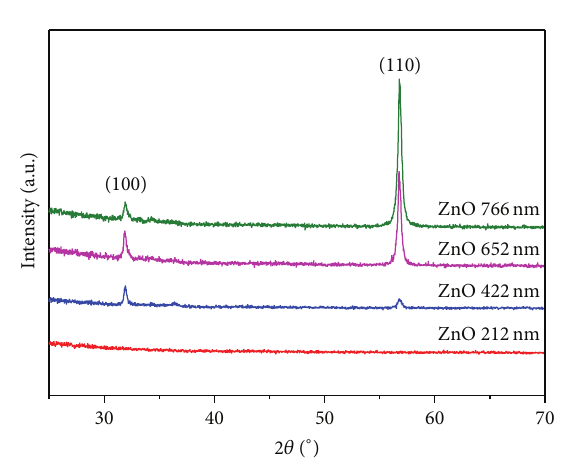
Figure 3: Structural properties of ZnO films at various thicknesses. The deposition temperature was 146 ∘